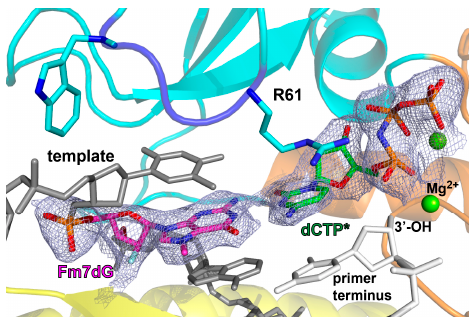
Figure 5. Pol η accommodating the Fm7dG:dCTP* base pair in the catalytic site. Close-up view of Fm7dG:dCTP* in the replicating base pair site of pol η . A 2Fo-Fc electron density map contoured at 1 σ around Fm7dG:dCTP* is shown. The active site Mg 2+ ions are shown in green spheres. Arg61, which interacts with the incipient base pair, is shown in cyan sticks. The color scheme is the same as in Figure 3A. The Arg61–Trp64 loop is shown in blue.